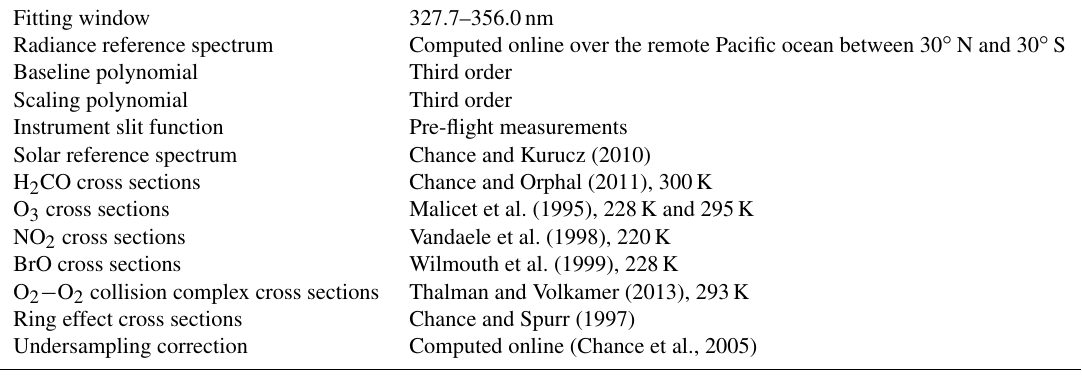
Table 1. Fitting window and parameters used in the retrieval of H 2 CO differential slant column densities.